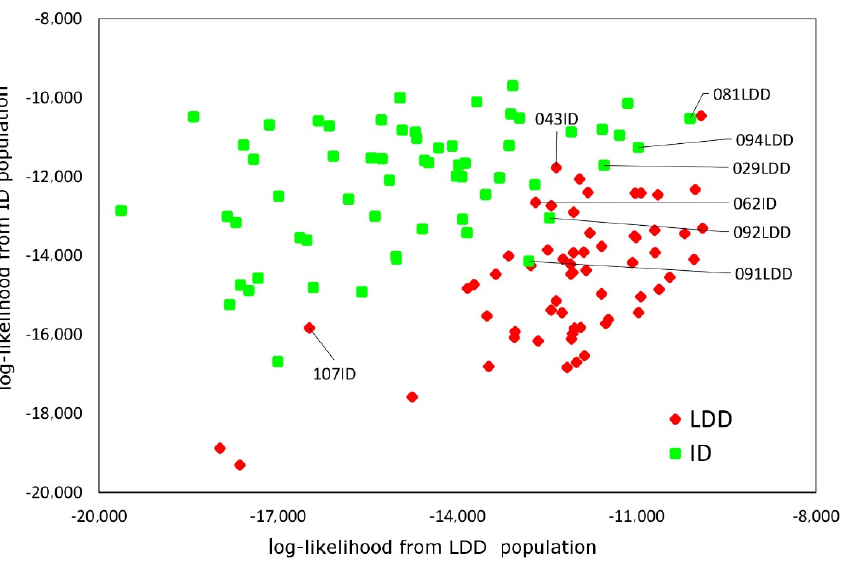
Figure 5. Plot shows the population assignment test for the Littoral-Dinaric donkey (LDD, n = 60) and the Istrian donkey (ID, n = 60). Each point represents an individual donkey. Individuals assigned to a different population are marked. For example, individual 043ID, which originally belonged to the Istrian donkey population (green), was assigned to the Littoral-Dinaric donkey population (red). The genotype’s expected frequency are log-transformed, and it gives the log likelihood of occurrence for each population.